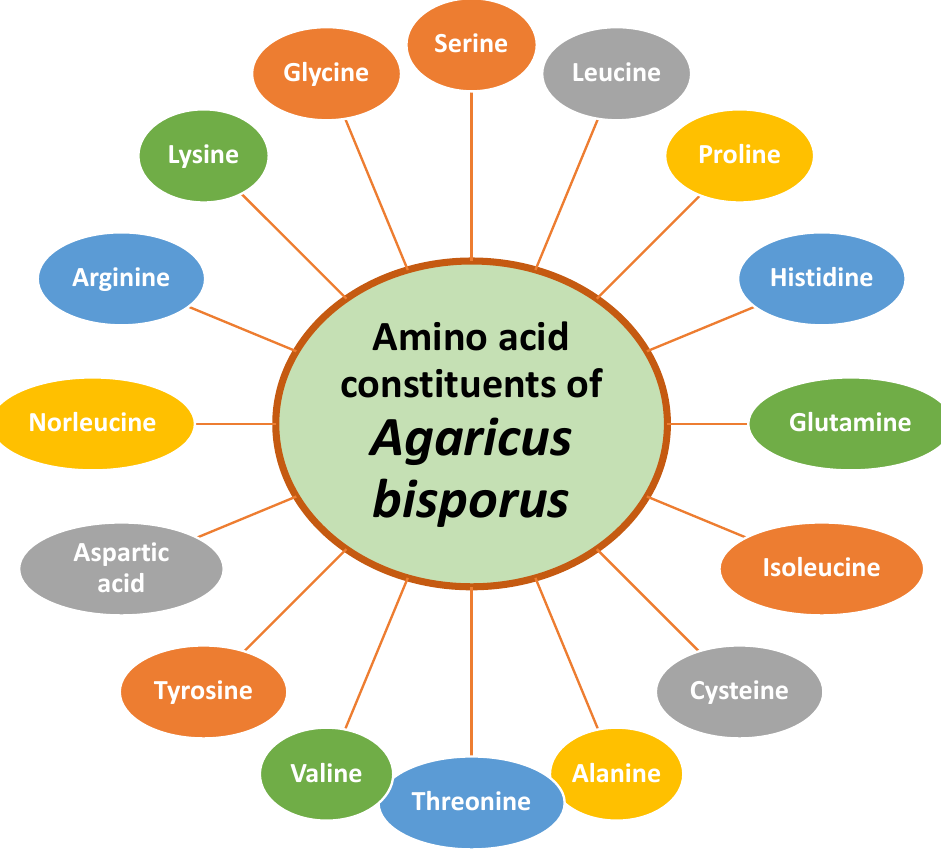
Figure 2. Amino acid constituents in Agaricus bisporus [43].